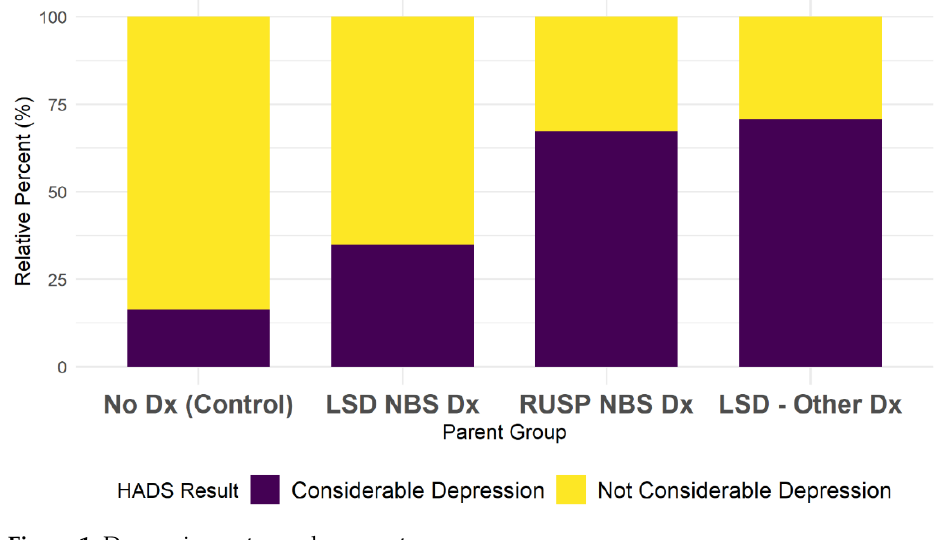
Figure 1. Depression outcome by parent group. Table 2. Results of bivariate analyses for the association between covariates and HADS/PSS outcomes.